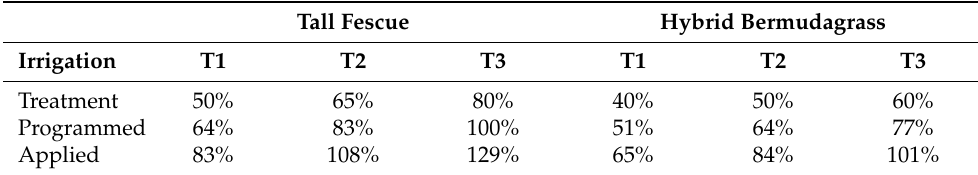
Table 2. Target irrigation treatments (T1–T3) versus programmed and applied irrigation